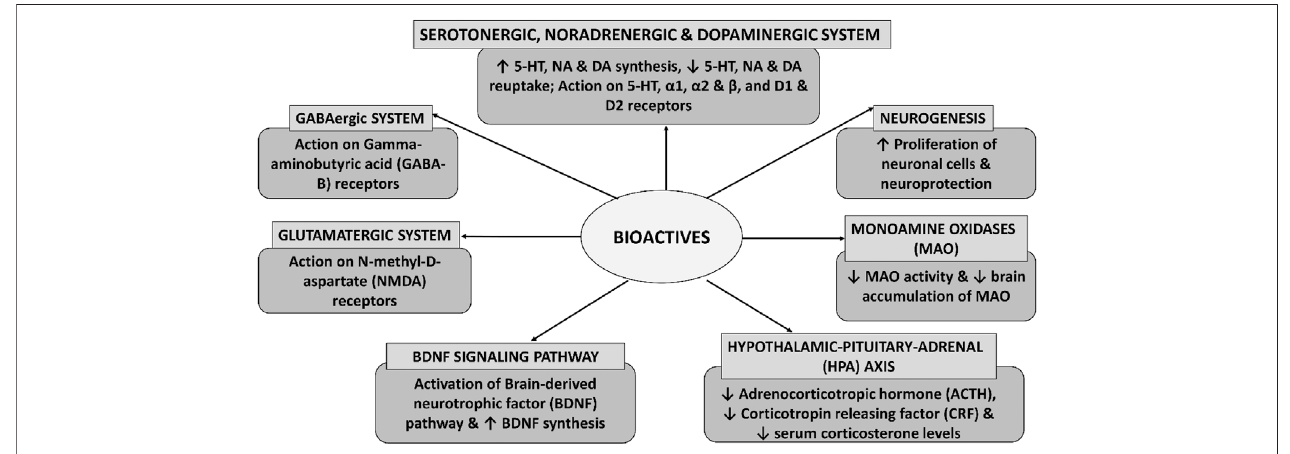
FIGURE 5 | Illustration of the molecular mechanisms mediated by the bioactives for depression management.